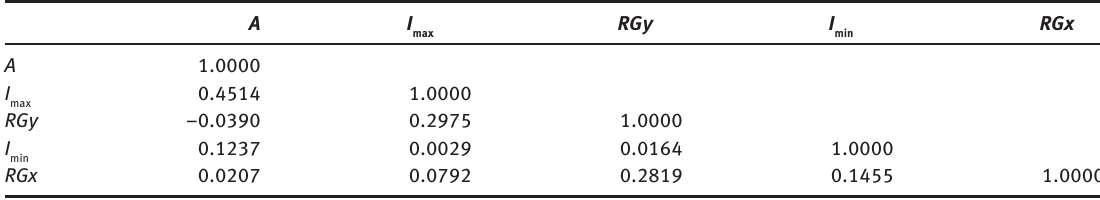
Table 3: Covariance Matrix of Features.